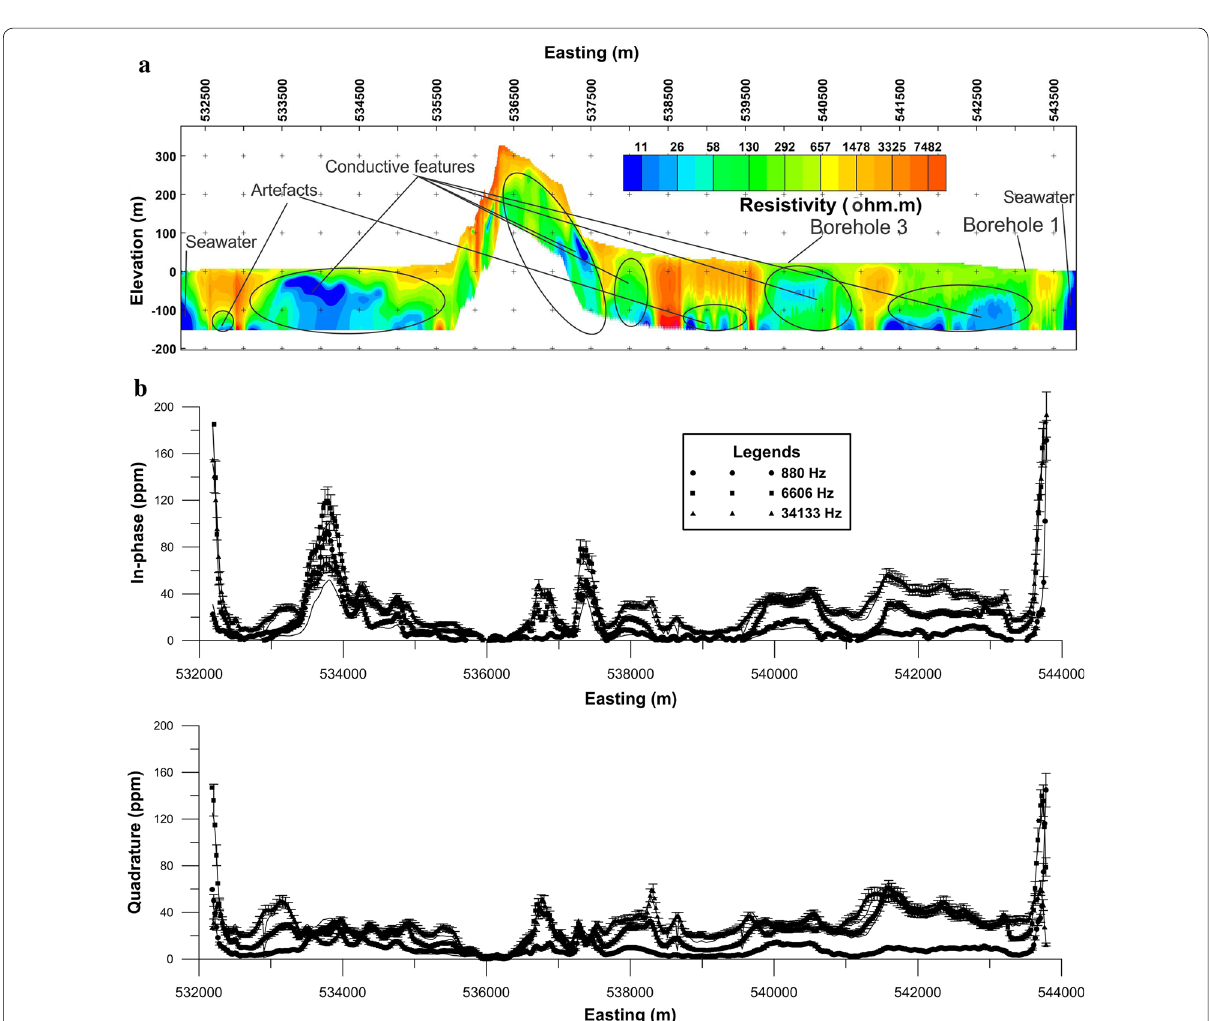
Fig. 7 a HEM resistivity section along a HEM line passing through boreholes 1 and 3. b Fitting between observed HEM data (symbols with error bars) and computed data (solid lines) from quasi‑3D inversion. See Fig. 1 for